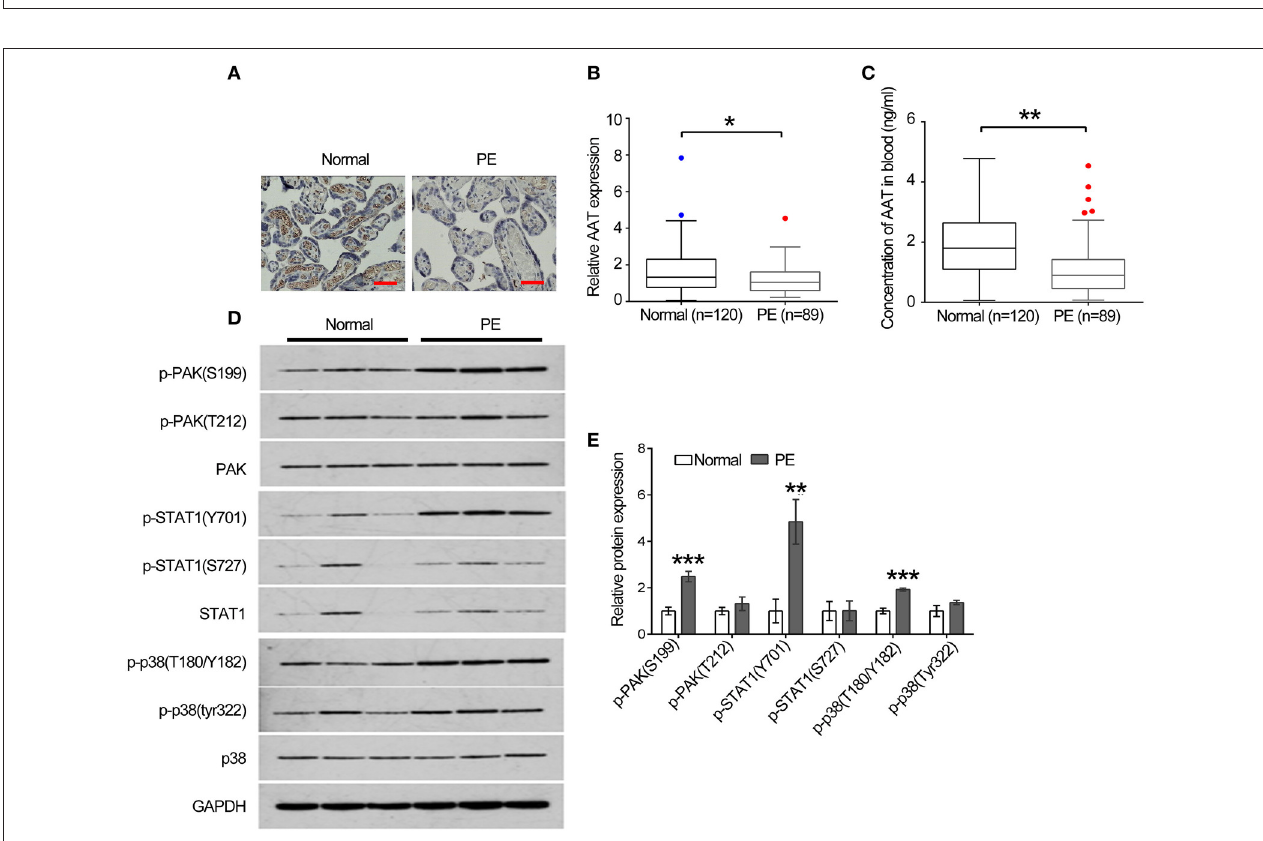
FIGURE 6 | The expression of AAT was dramatically decreased in blood and placenta tissues from PE patients. (A) Representative images of IHC staining for AAT. Bar = 50 µ m. (B) AAT expression was decreased in placenta from PE patients. (C) ELISA was used to detect the concentration of AAT in blood from PE patients. (D) Western blot analysis for PAK, phosphorylated PAK, STAT1, phosphorylated STAT1, p38 and phosphorylated p38 in human placenta. (E) Quantification of the band in (C) . * p < 0.05 , ** p < 0.01 , *** p < 0.001 .